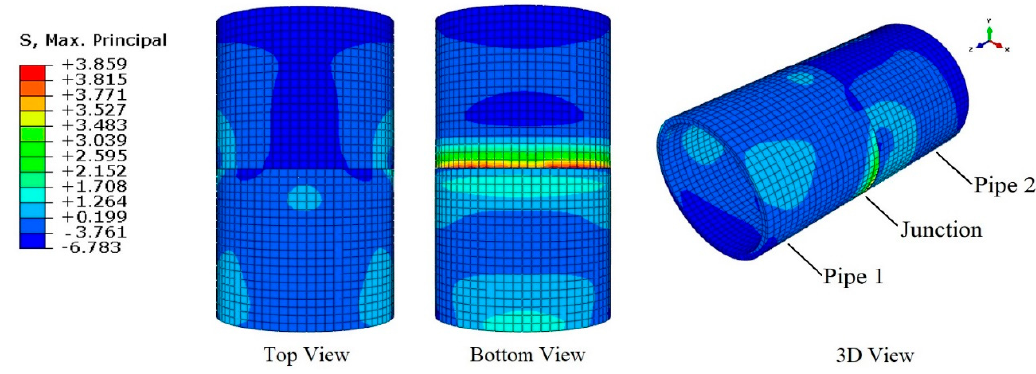
Figure 13. Stresses in the pipe wall under steady flow conditions (MPa).